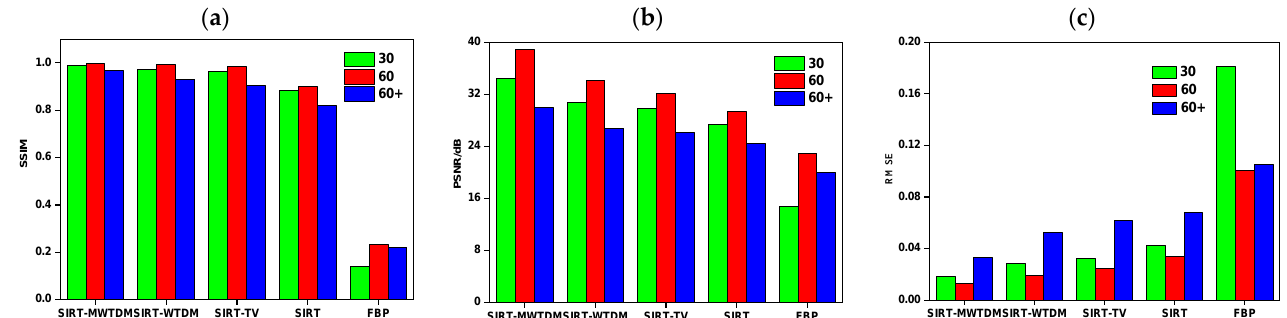
Figure 4. The histograms of evaluation index for reconstructed images of the Shepp–Logan phantom with different numbers of projections. ( a ) SSIM; ( b ) PSNR; ( c ) RMSE. Here, 60+ indicates that Poisson noise is added to 60 projections.